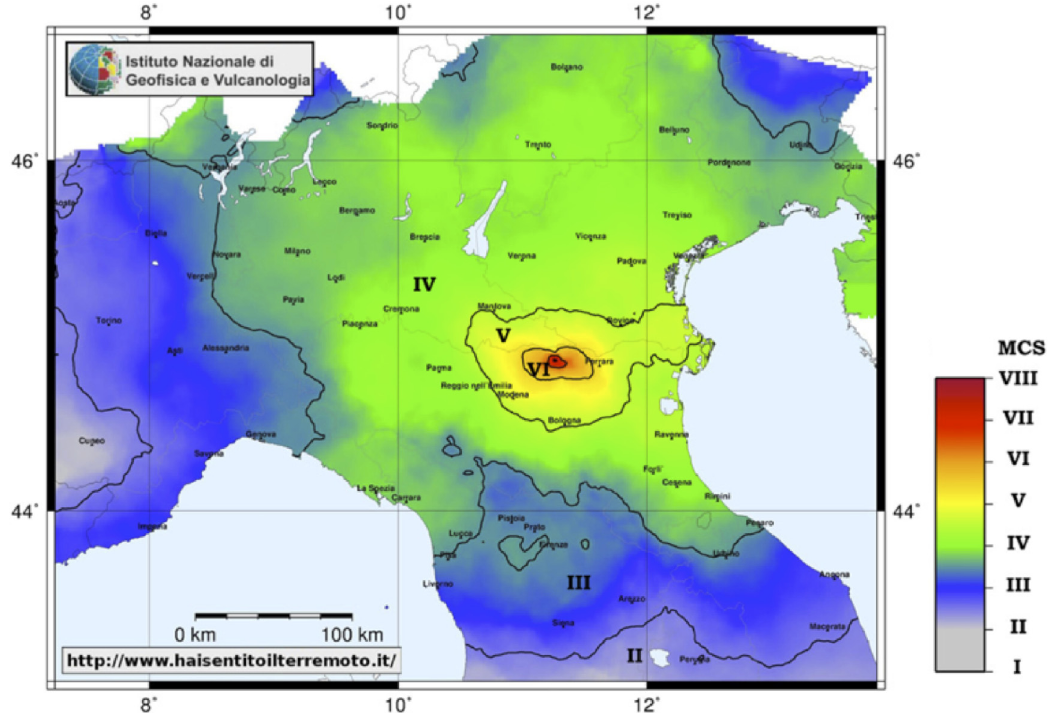
Figure 2. Macroseismic intensity map created by INGV through the online survey www.haisentitoilterremoto.it and referring to the 02:03:52 a.m. UTC earthquake on May 20, 2012. Source: